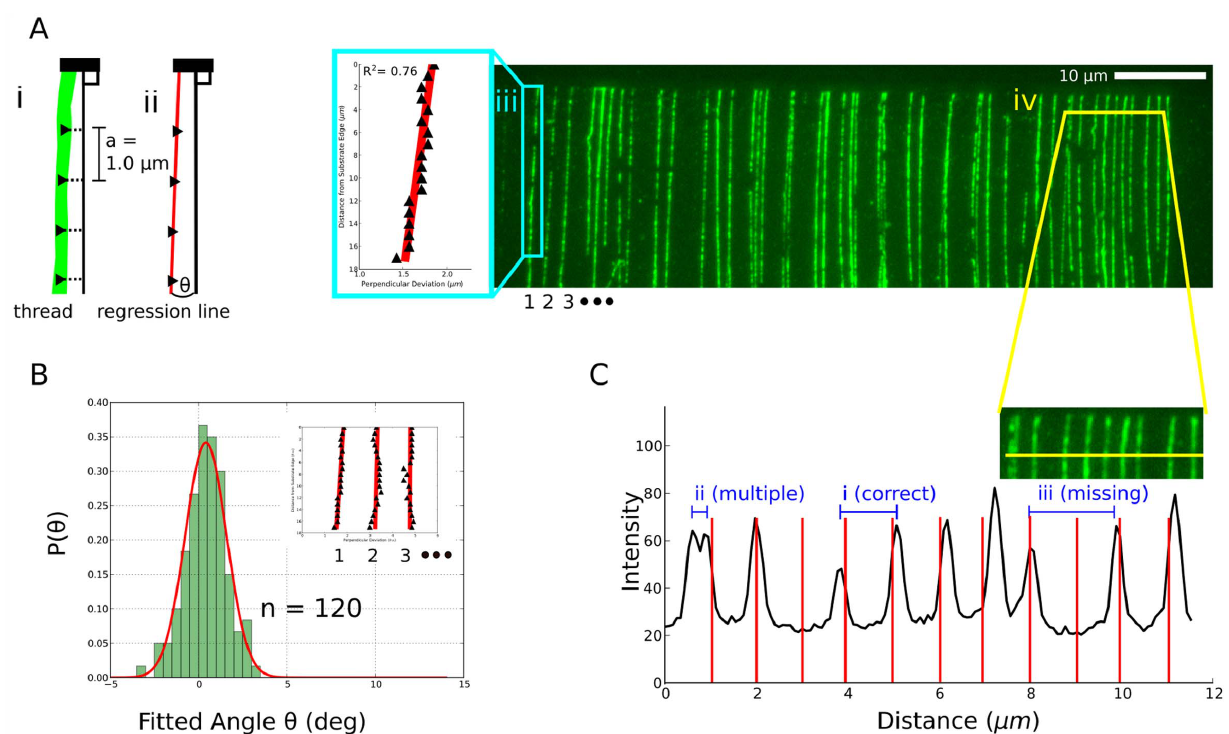
Figure 3. Characterization of threaded DNA arrays by fluorescence microscopy. ( A ) Left: Scheme for determining the angle of a thread. ( i ) The horizontal position of a fluorescent trace of a YOYO-1 stained thread is measured at a series of vertical positions in 1.0 m m increments. The vertical axis is defined to be perpendicular to the edge of the target substrate. ( ii ) A regression line is fit to the horizontal position measurements and used to define the angle of the thread with respect to the vertical axis. Right: Wide-field fluorescent image of an array of YOYO-1 stained threads of ssDNA molecules generated by rolling circle amplification of m13mp18 ssDNA. ( iii – blue box ) Example of the use of linear regression to measure the angle of the left-most thread. ( iv – yellow cross-section ) Horizontal profile spanning 10 individual threads. ( B ) Histogram of angles determined for 120 threads compiled from two arrays prepared at different locations on an elastomer substrate. Inset: regression curves for three individual threads from the image in (A). ( C ) Illustration of successful and failed threading across 11 needle insertions (area sampled from (A)). ( i ) Successful threading: two adjacent threads are present with the desired spacing determined by the programmed lateral translation of the needle after each insertion. ( ii ) Two intertwined threads captured by the needle on a single insertion. ( iii ) No thread is present at the corresponding needle insertion position.